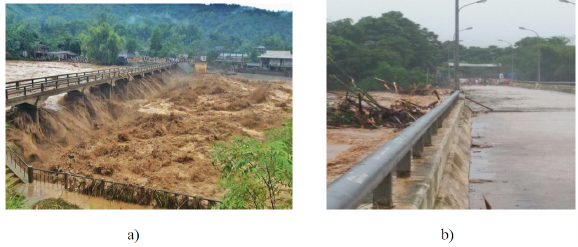
Fig. 1. Water flow impacting bridge structures: a) Nghia Lo bridge in Yen Bai, Viet Nam, was partially inundated after heavy rains in 2017; b) Canh Nang bridge in Thanh Hoa, Viet Nam, was partially inundated under dam-break flow in 2018